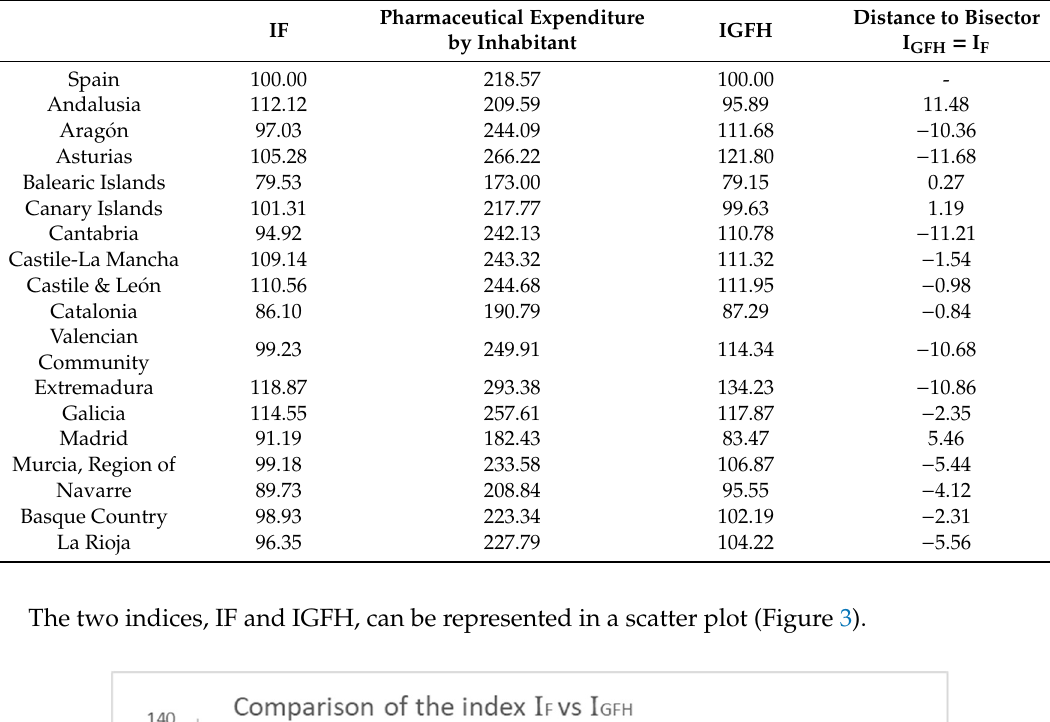
Table 3. Indices IF, Pharmaceutical Expenditure by Inhabitant and IGFH.